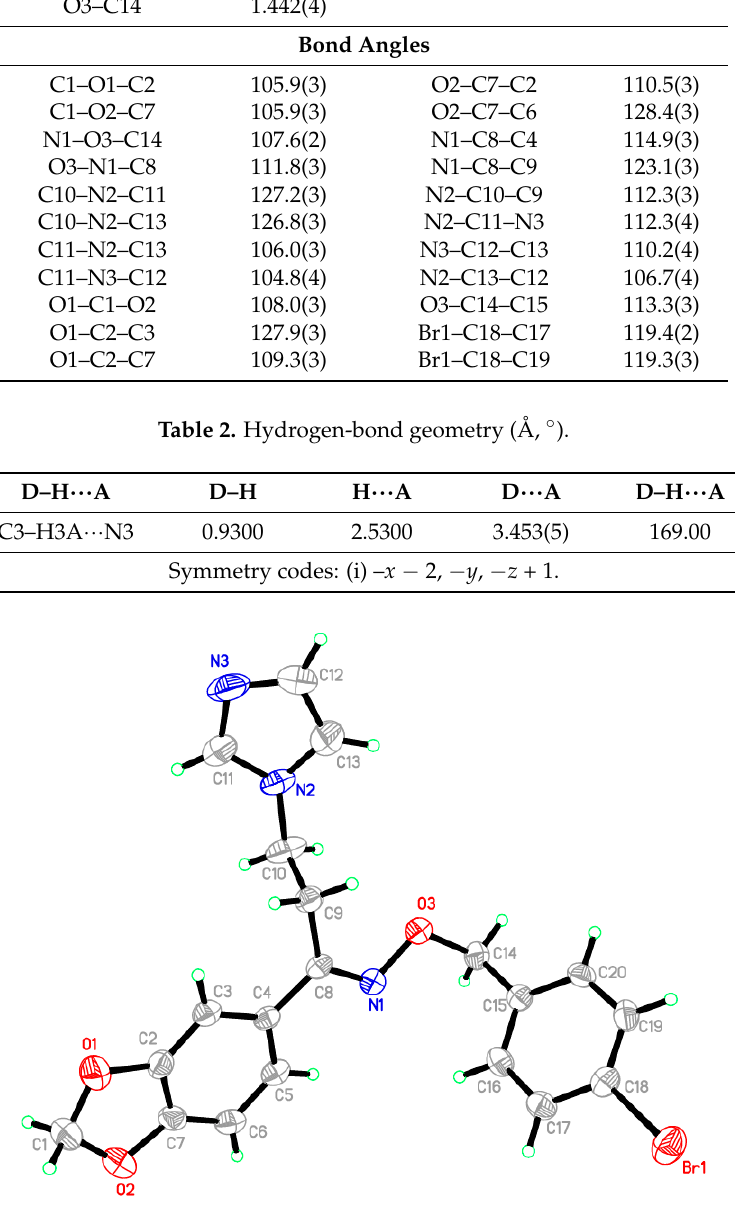
Figure 2. ORTEP diagram of compound Vi . Displacement ellipsoids are plotted at the 40% probability level for non-H atoms.